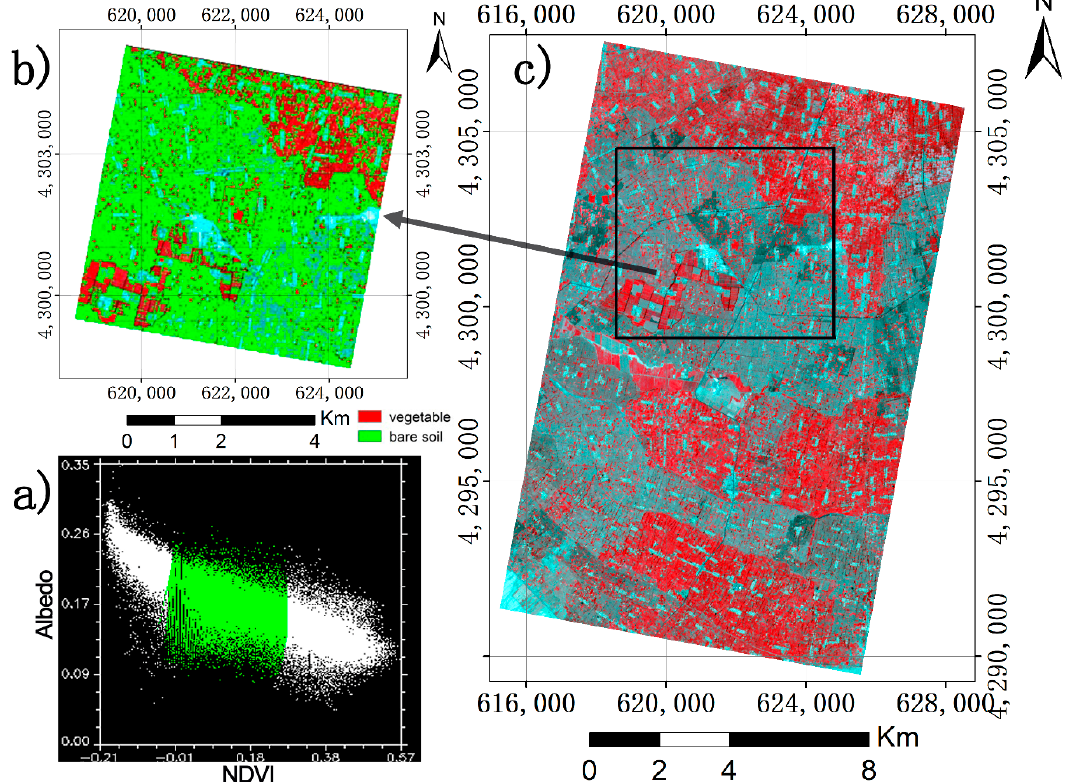
Figure 16. ( a ) The normalized difference vegetation index (NDVI)-albedo scatter plot of a small square extracted from ( b ) an enlarged and bare soil dominated area of ( c ) the study area.